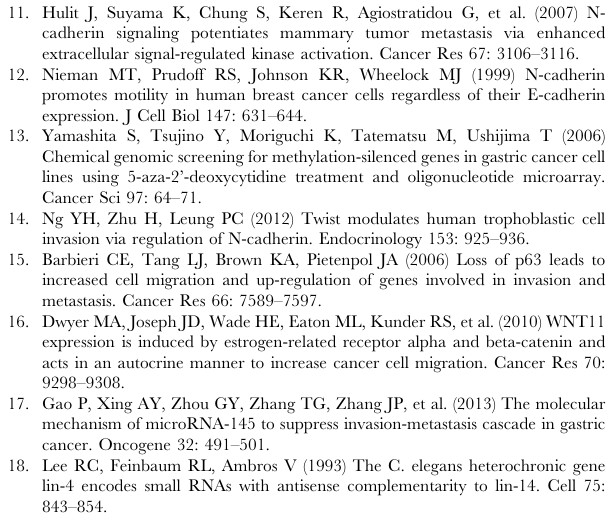
aggressive lung adenocarcinoma cell lines. (A) Quantita- tive RT-PCR of CDH2 in the aggressive cell line H1299 and